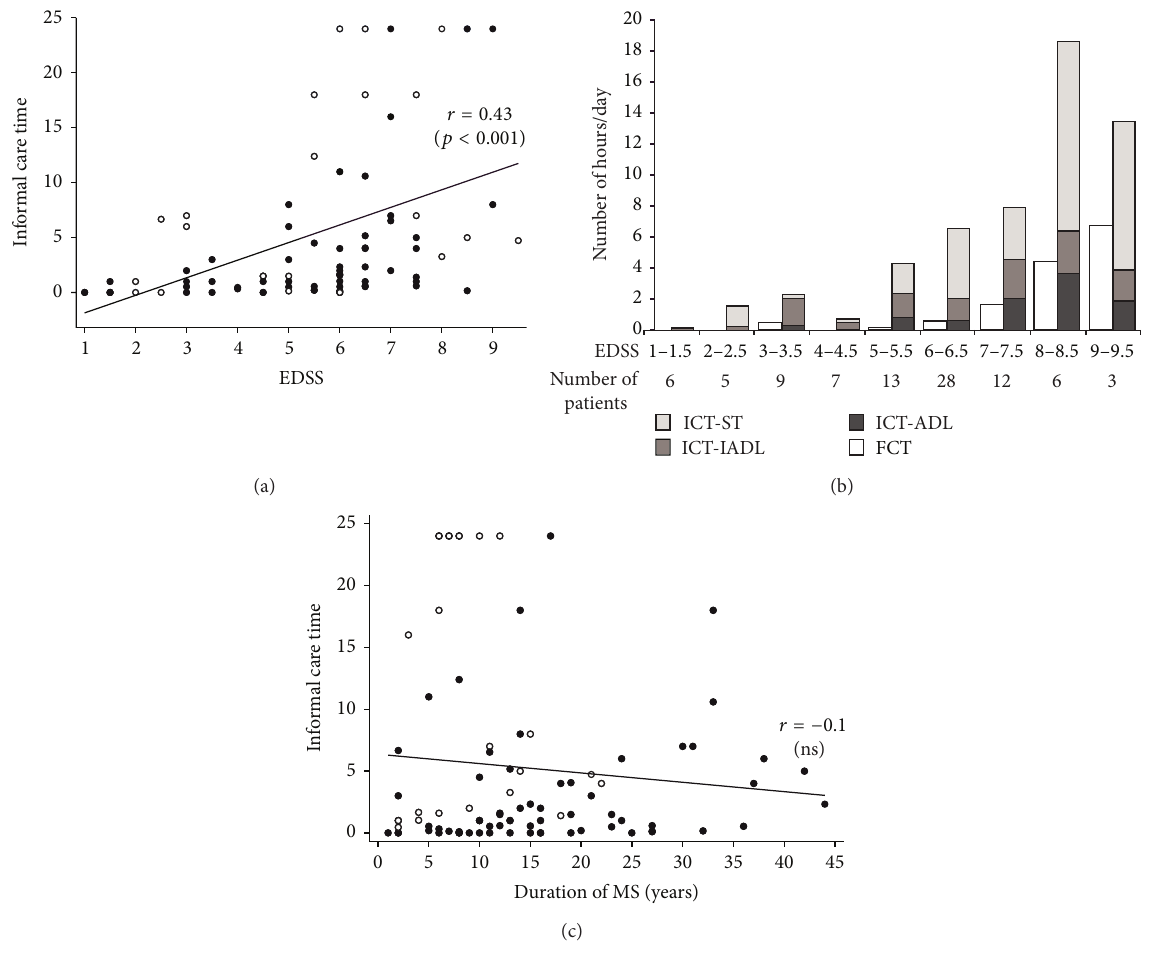
Figure 1: Informal caregiver objective burden (informal care time (ICT)): (a) scatterplots of the correlation between EDSS score and ICT. White dots signify that patient’s Dysexecutive questionnaire score is over 75th percentile (otherwise dark dots), (b) ICT-sub activities and formal care time (FCT) as a function of EDSS. ADL = Activities of Daily Living; IADL = Instrumental Activities of Daily Living; ST = Supervision Time, and (c) scatterplots of the correlation between MS duration and ICT. White dots specify fast progressors (i.e., patients with a rapid disability course identified in the Multiple Sclerosis Severity Score [9, 13] table over the 8th decile) and dark dots specify